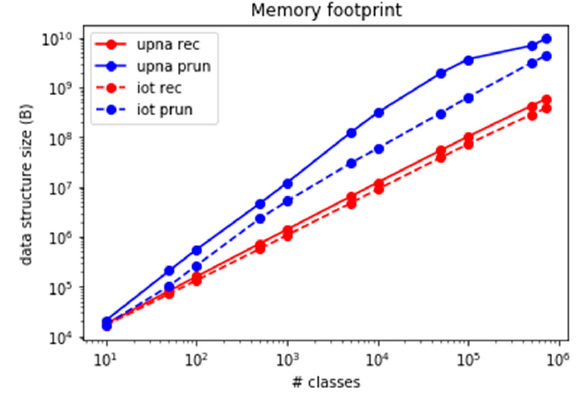
Figure 15. Number of devices supported, depending on the traffic generated per IoT device ( a ) extracting 6 time series per device, or ( b ) extracting 10 time series per device.